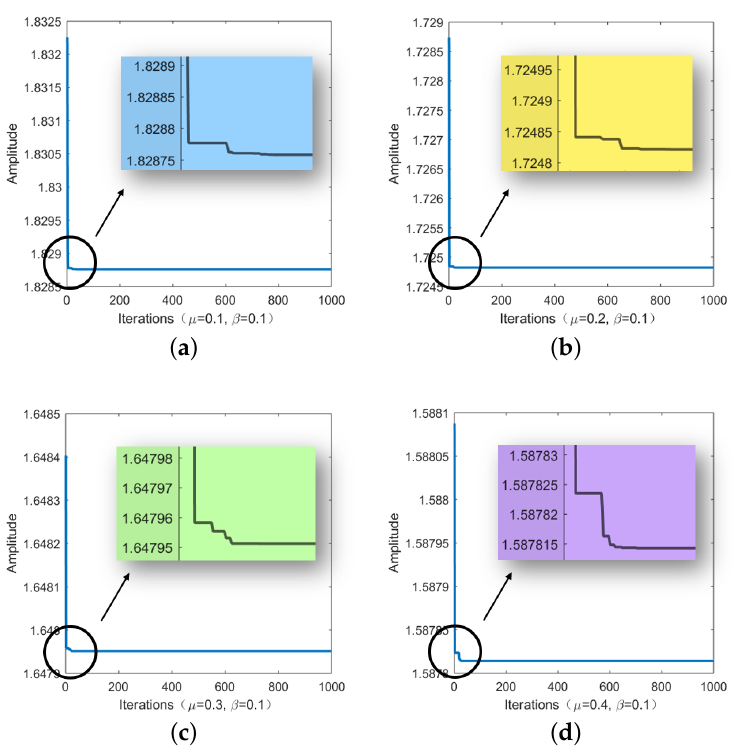
Figure 8. Iterations when optimizing the single variable ξ ( α 2 opt = α 2 b , β = 0.1): ( a ) µ = 0.1; ( b ) µ = 0.2; ( c ) µ = 0.3; ( d ) µ = 0.4.